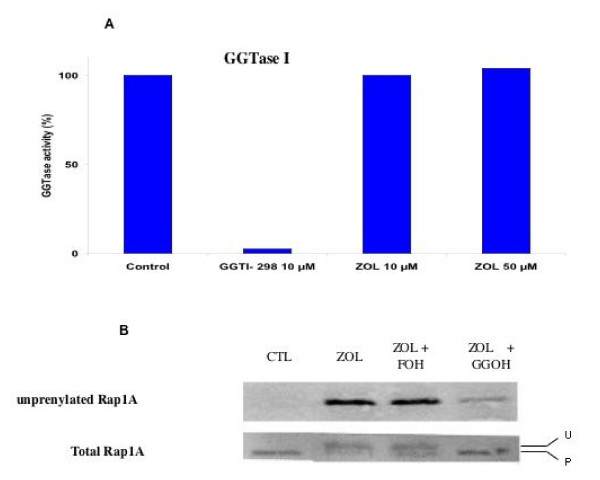
Effect of zoledronate on GGPP/GGOH incorporation into proteins in vitro (A) and in vivo (B). A: Geranyl-geranyl transferase I (GGTase I) was quantified using an in vitro test based on [3H]-prenyl pyrophosphate (0.5 μM, 8–10 Ci/mmol) incorporation into a mutant form of H-ras with a geranyl-geranylation CAXX box. The level of prenylation is expressed as a percentage of maximum incorporation of [3H]-prenyl, as determined by allowing the uninhibited reaction to go to completion. B: Western-blot analysis; PC-3 cells are treated by vehicle, ZOL 20 μM; ZOL 20 μM + FOH 10 μM; ZOL 20 μM + GGOH 10 μM.